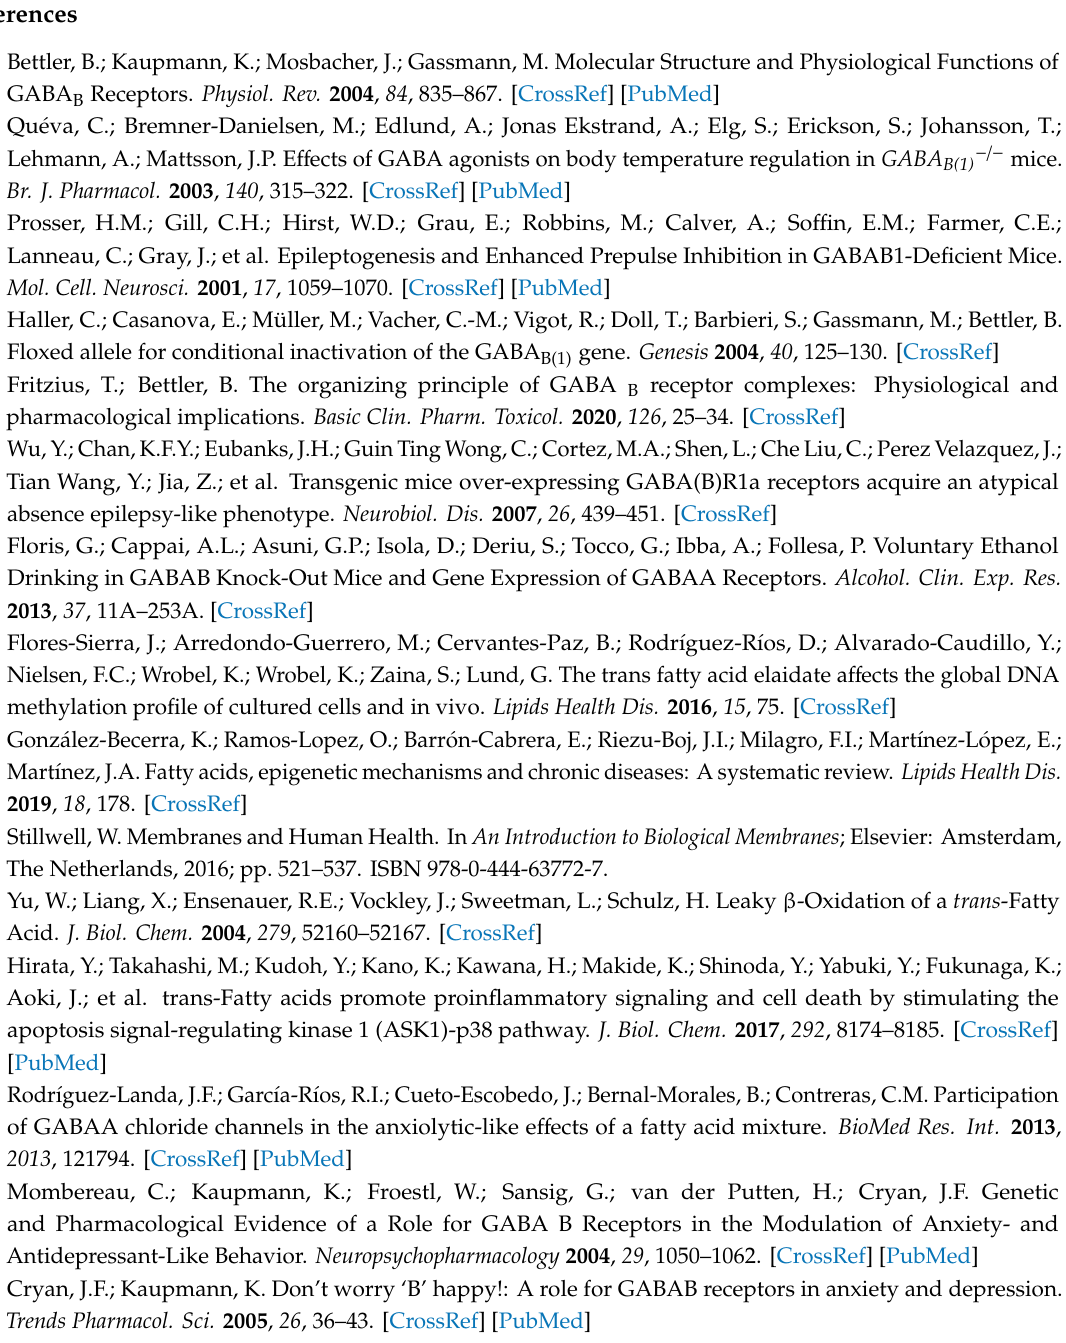
Figure S1: GC-MS chromatograms of pure standards of trimethylsilyl esters of oleic and elaidic acid, Figure S2: Mass spectrum of oleic acid trimethylsilyl ester: retention time 16.927 min., Figure S3: Mass spectrum of elaidic acid trimethylsilyl ester: retention time 16.984